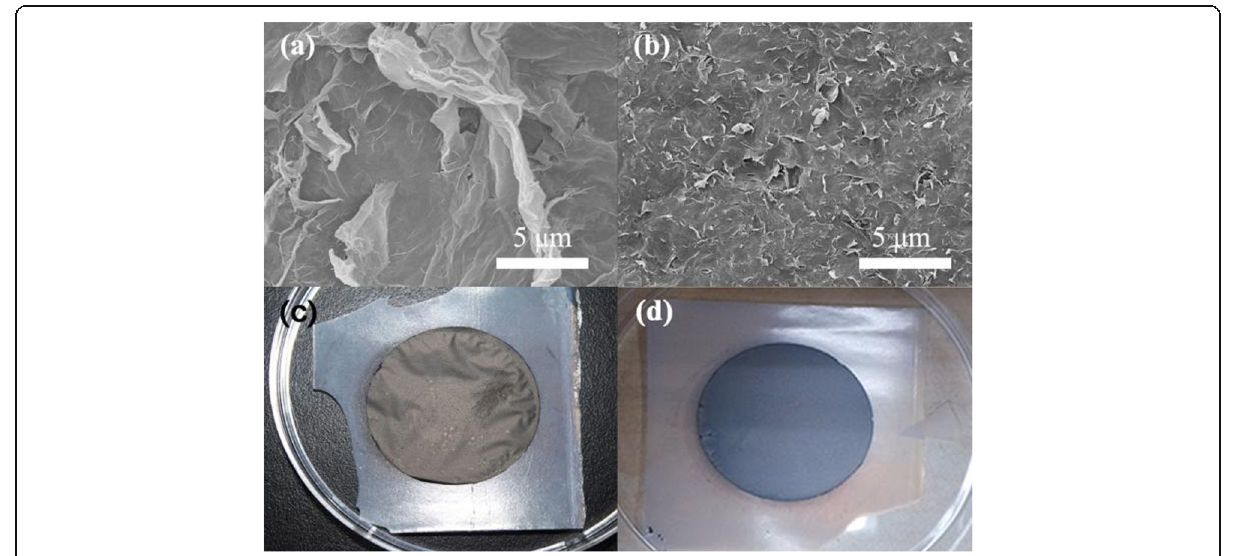
Fig. 4 a , c SEM images and b , d digital camera images of (a, b) GP-1 and (b, d)